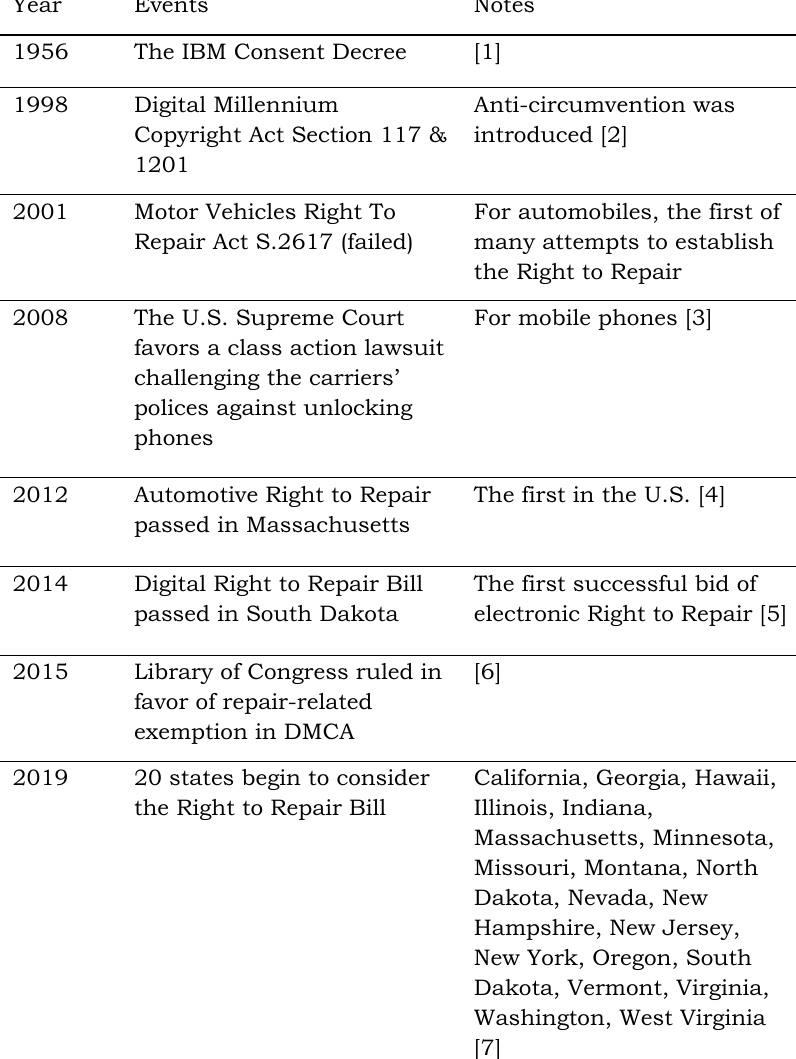
Table 1. Major events of “the Right to